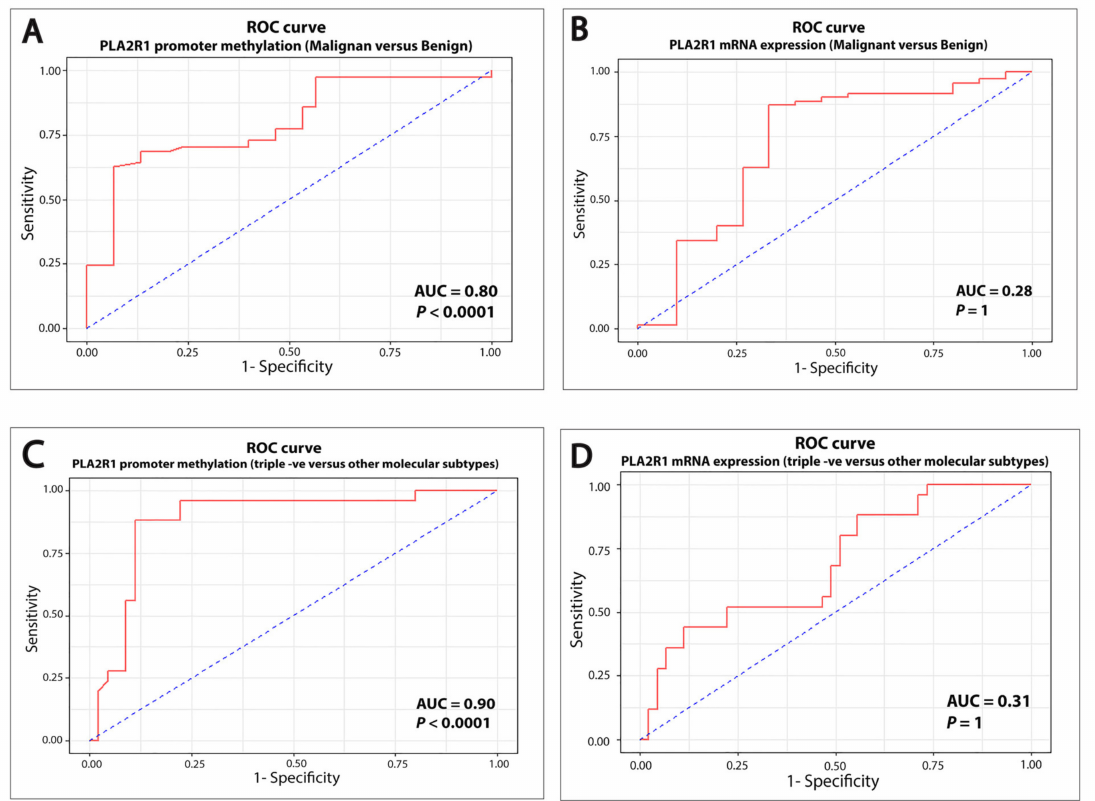
Figure 4. PLA2R1 promoter methylation discriminated two distinct subgroups of breast cancer based on ROC curve analysis. ( A , B ) ROC curve analysis demonstrating that PLA2R1 promoter methylation was more accurate than PLA2R1 expression in discriminating breast cancer from benign fibroadenomas. ( C , D ) ROC curve analysis demonstrating that PLA2R1 promoter methylation surpassed PLA2R1 expression in discriminating TNBC tumors from other molecular subtypes of breast